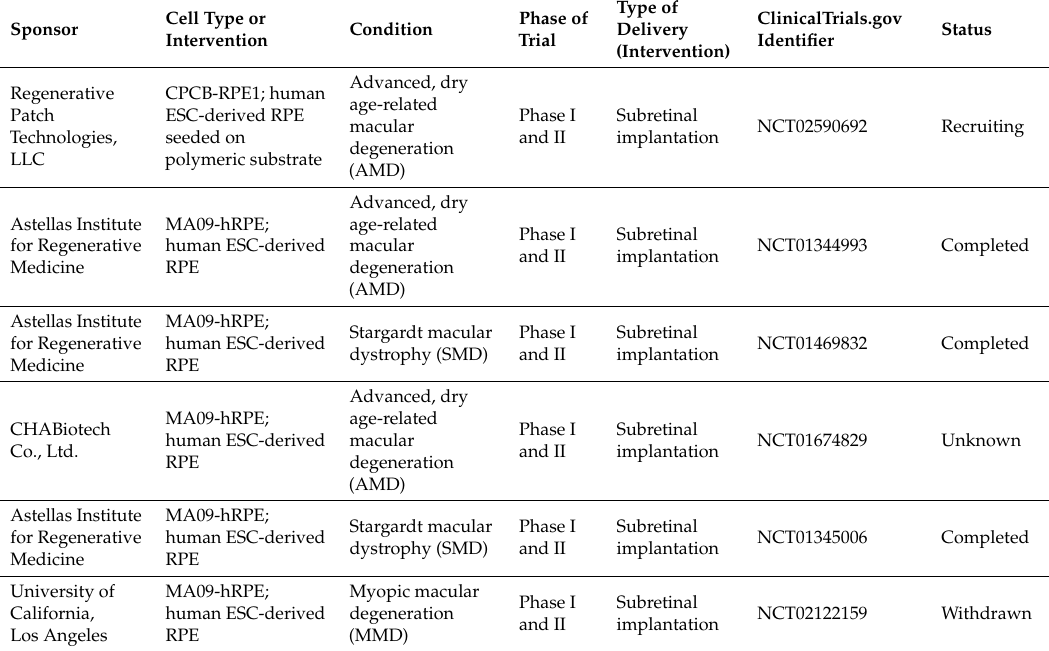
Table 1. ESC and iPSC-derived RPE-based cell types in clinical trials for inherited and non-inherited macular degeneration. Study type: Interventional. Last updated 25 October